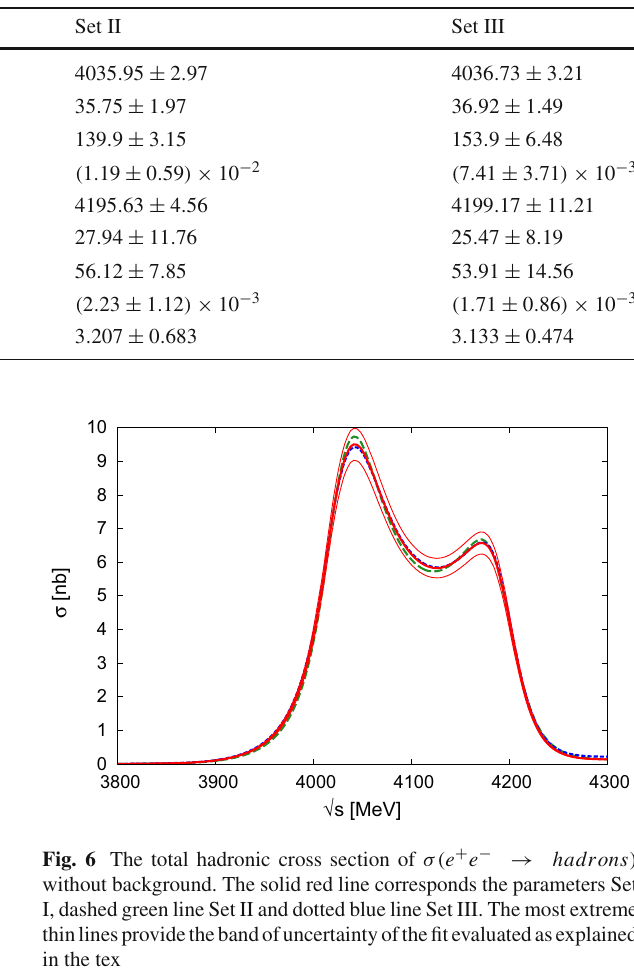
ones, such as to obtain the peak position as in the